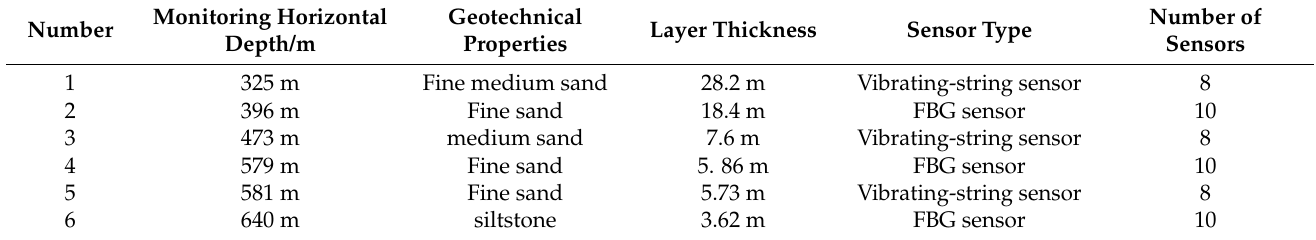
Table 2. FBG and vibrating-string sensor arrangement of each layer.